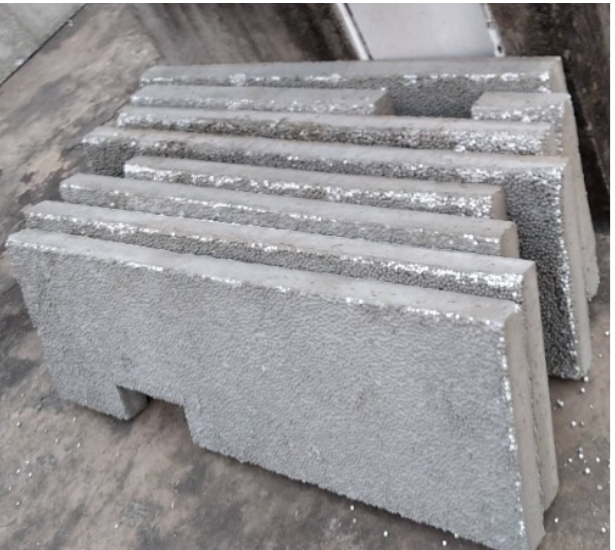
Figure 7. Prefabricated Panels.